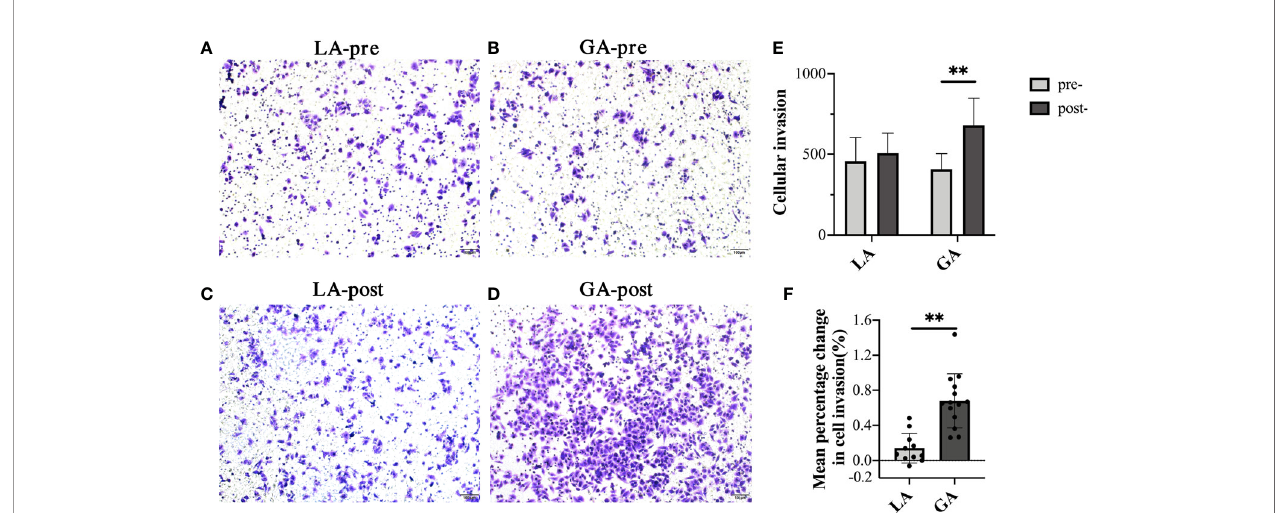
FIGURE 2 | Serum from RFA patients receiving GA facilitated cell invasion of HepG2 cells. (A) Representative image of pre-LA serum-treated HepG2 cells; (B) Representative image of pre-GA serum-treated HepG2 cells; (C) Representative image of post-LA serum-treated HepG2 cells; (D) Representative image of post-GA serum-treated HepG2 cells; Original magni fi cation, 100X; (E) Graphical representation of cells that invaded the lower surface of the four groups; (F) Graphical representation of the mean percentage change from post- to preoperative values of invading cell numbers in the GA group vs the LA group. Values are expressed as mean ± SD. n = 11, LA group. n = 14, GA group. ** P < 0.01. GA, General Anesthesia; LA, Local